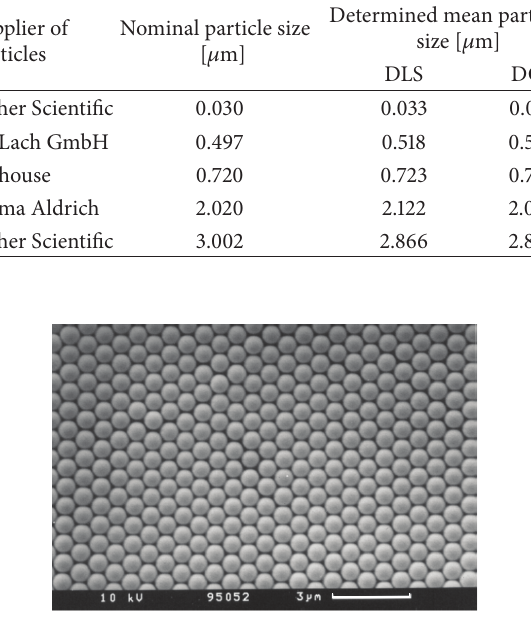
Figure 1: REM picture of in-house produced polystyrene particles